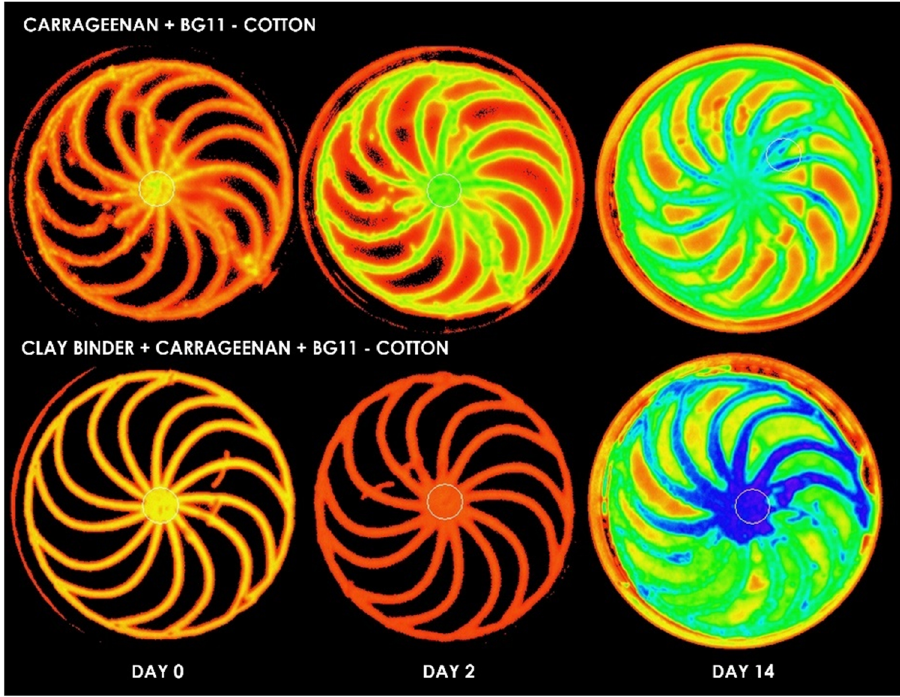
Figure 8: 3D printed patterns on cotton using kappa – carrageenan ( top ) and Auro Clay Paint ( bottom ) , image showing cell chlorophyll fl uorescence in I - PAM, red and yellow indicate low levels of fl uorescence of living photosynthetic cells, green and blue indicate higher levels, and black indicates a lack of living photosynthetic cells. The dense green areas on day 14 indicate cell migration outside of the printed area.